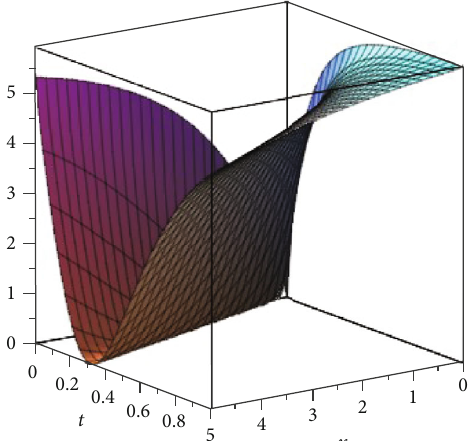
ð x , 0, 0, t Þ of Equation Figure 18: u 1,5